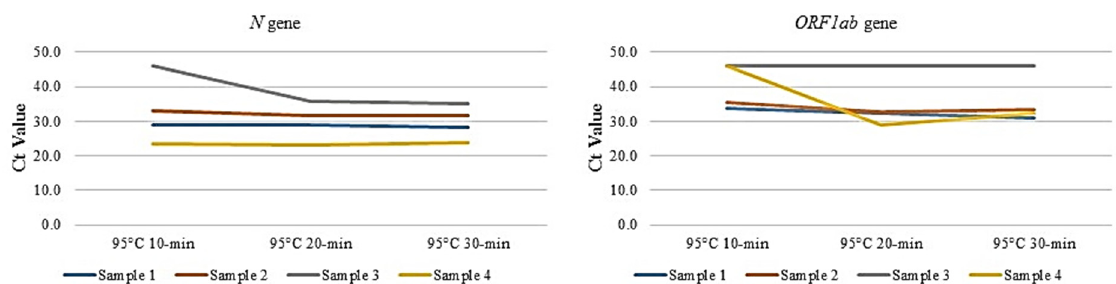
Figure 2. N and ORF1ab gene Ct values of four previously tested positive samples treated at 95 ◦ C for 10, 20, and 30 min followed by homogenization and direct RT-PCR. Ct value of 45 was considered as undetermined and used for